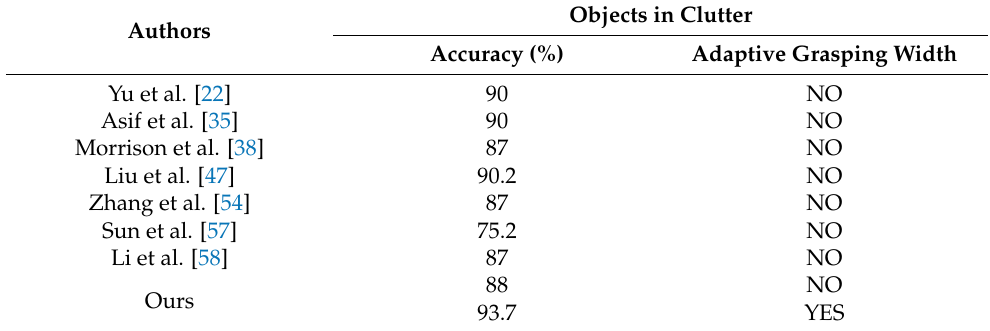
Table 6. Results in cluttered scenarios.